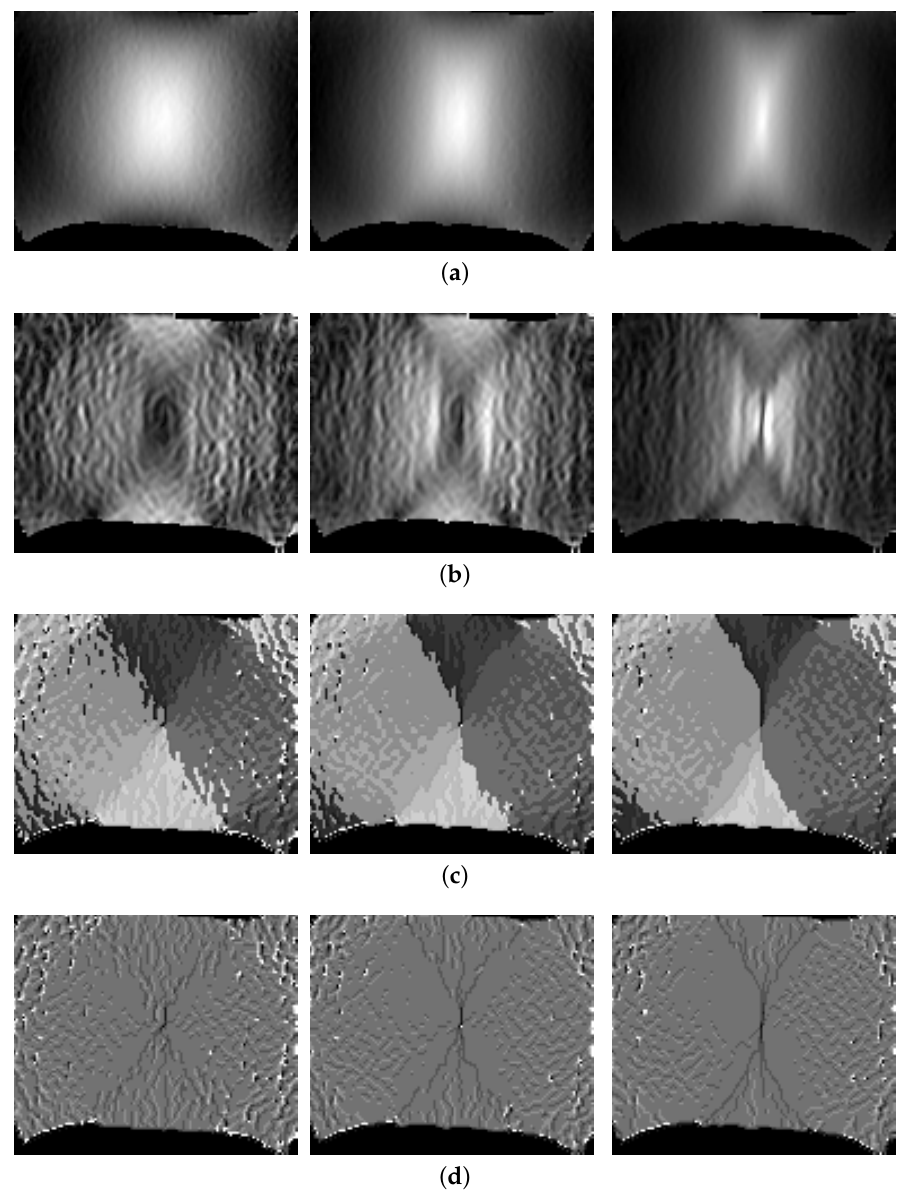
Figure 8. Major strain information in feature space and its progression over time: ( a ) Major strain distribution as greyscale image. ( b ) Sobel filtered gradient information. ( c ) Visualization of uniform LBPs. ( d ) Visualization of rotation invariant uniform